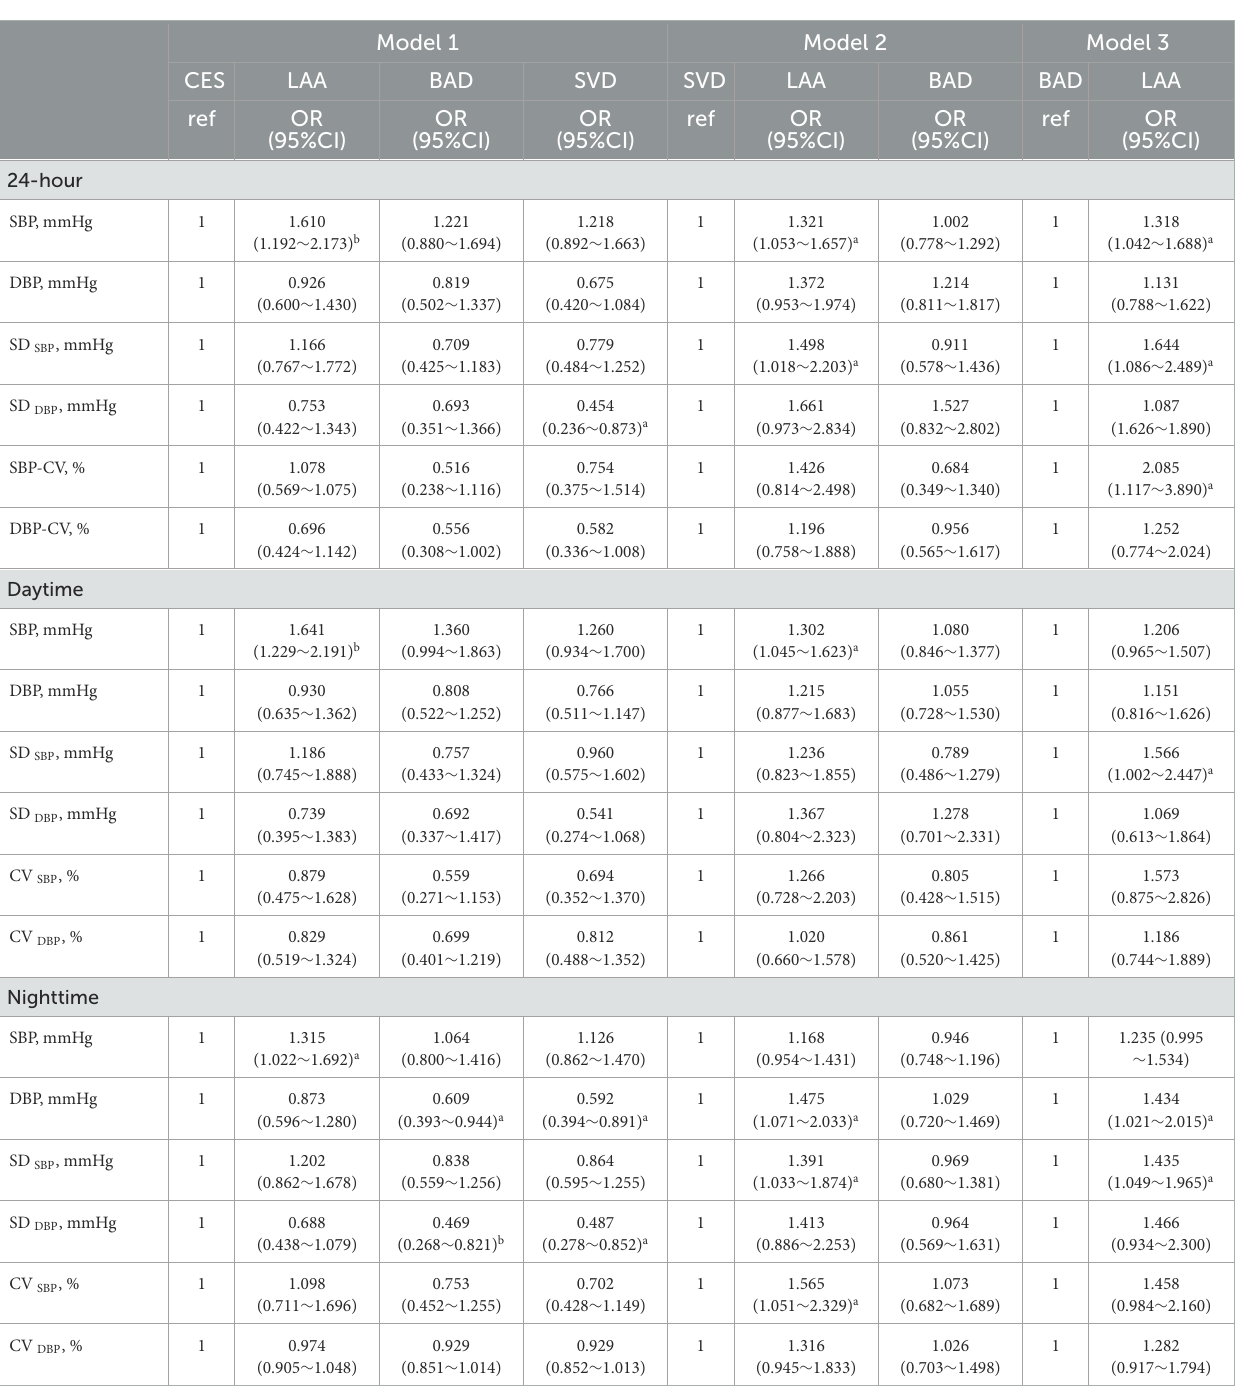
TABLE 3 Multinomial logistic regression analysis: association between 24-h ABP levels and stroke